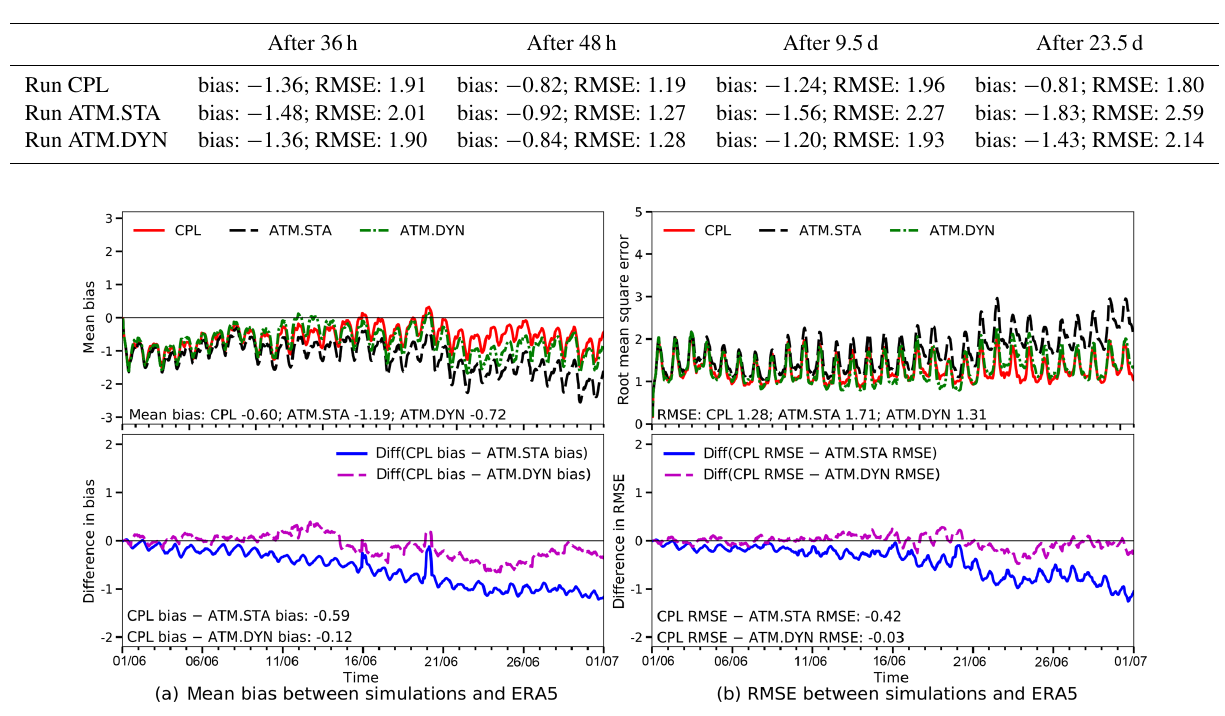
than ATM.STA (Jeddah: 4.98 ◦ C; Yanbu: 4.29 ◦ C) by